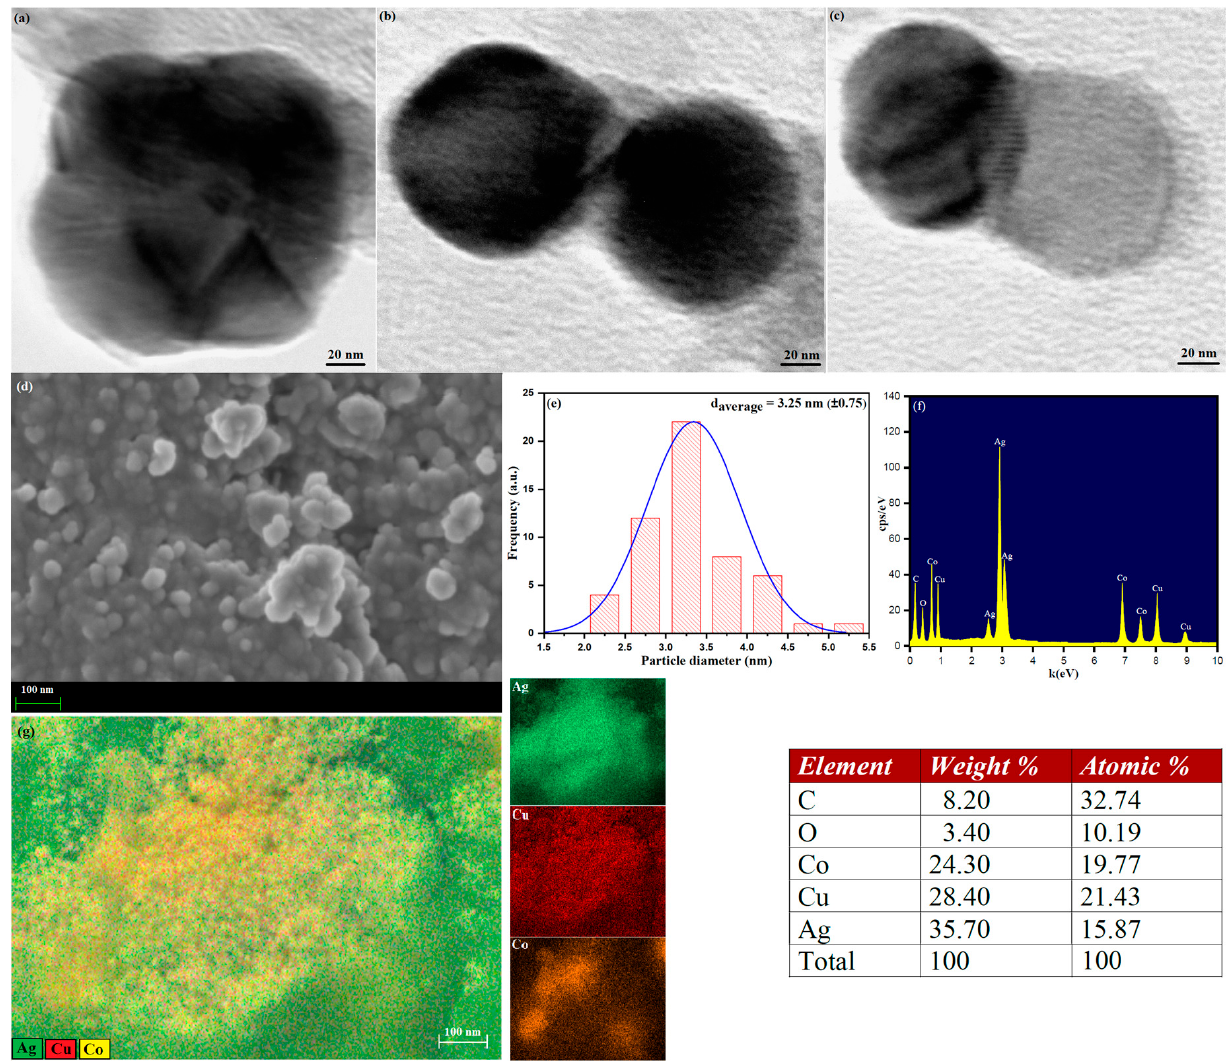
Figure 3. Transmission electron microscopy (TEM) images ( a – c ) single particle of Ag-Cu-Co trimetallic nanoparticles, ( d ) Scanning electron microscopy (SEM) image of Ag-Cu-Co trimetallic nanoparticles, ( e ) Particle size distribution histogram, ( f ) Energy-dispersive X-ray spectroscopy (EDX) elemental data of Ag-Cu-Co trimetallic nanoparticles and ( g ) Energy dispersive spectroscopy (EDS) elemental mapping images for Ag-Cu-Co trimetallic